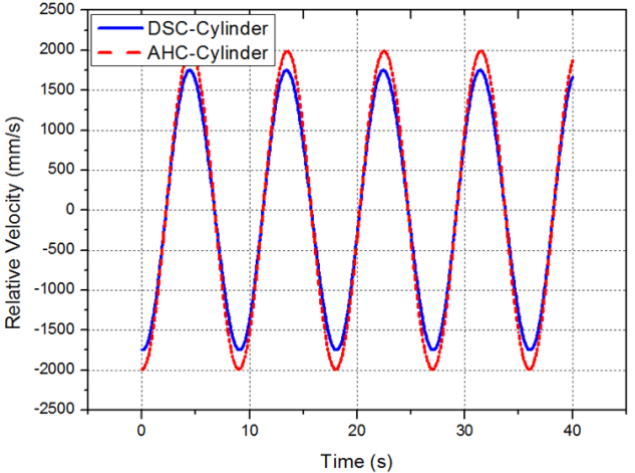
Figure 11. Velocity of the AHC and DSC cylinder.